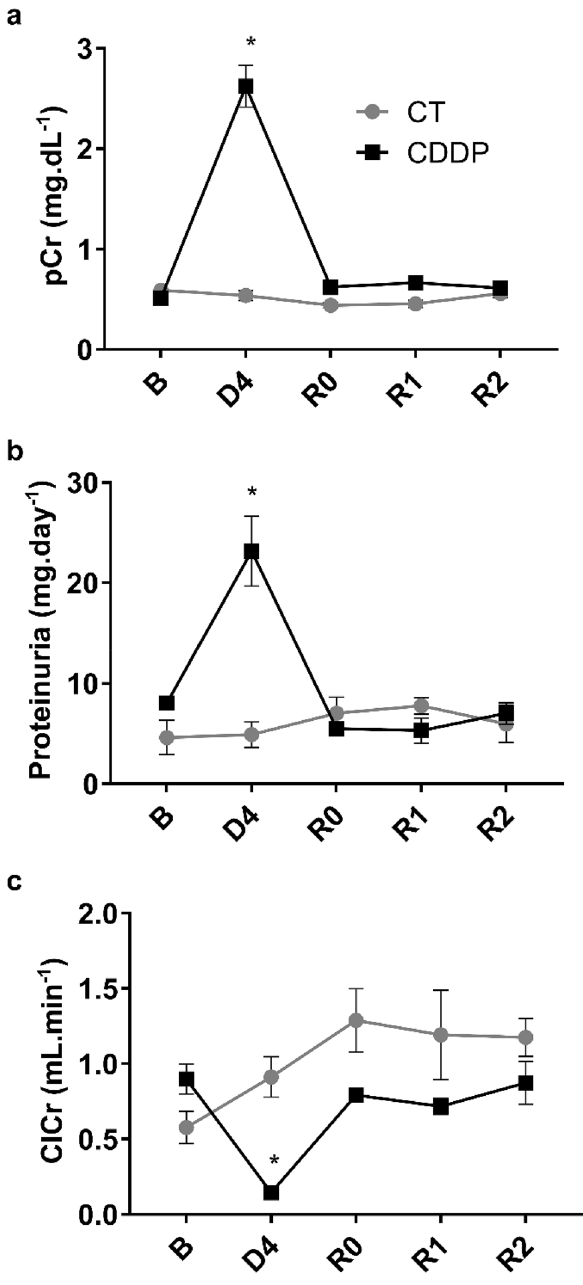
Figure 1. Renal function parameters: plasma creatinine (pCr) ( a ), proteinuria ( b ) and creatinine clearance (ClCr) ( c ). B basal, CDDP cisplatin treatment (5 mg kg −1 body weight) group, CT control group, D4 day of maximum kidney damage after cisplatin treatment, R0 day of recovery, R1 1 week after recovery; R2 2 weeks after recovery. P < 0.01: * versus